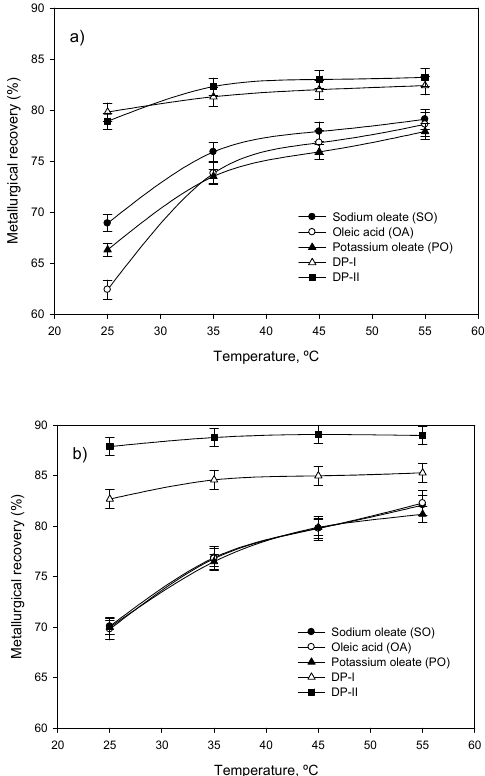
Figure8. E ff ectoftemperatureonfluoritemetallurgicalrecoveryinthemechanicalcell( a )andpneumatic Figure 8. Effect of temperature on fluorite metallurgical recovery in the mechanical cell ( a ) and pneumatic cell ( b ) froth flotation. cell ( b ) froth